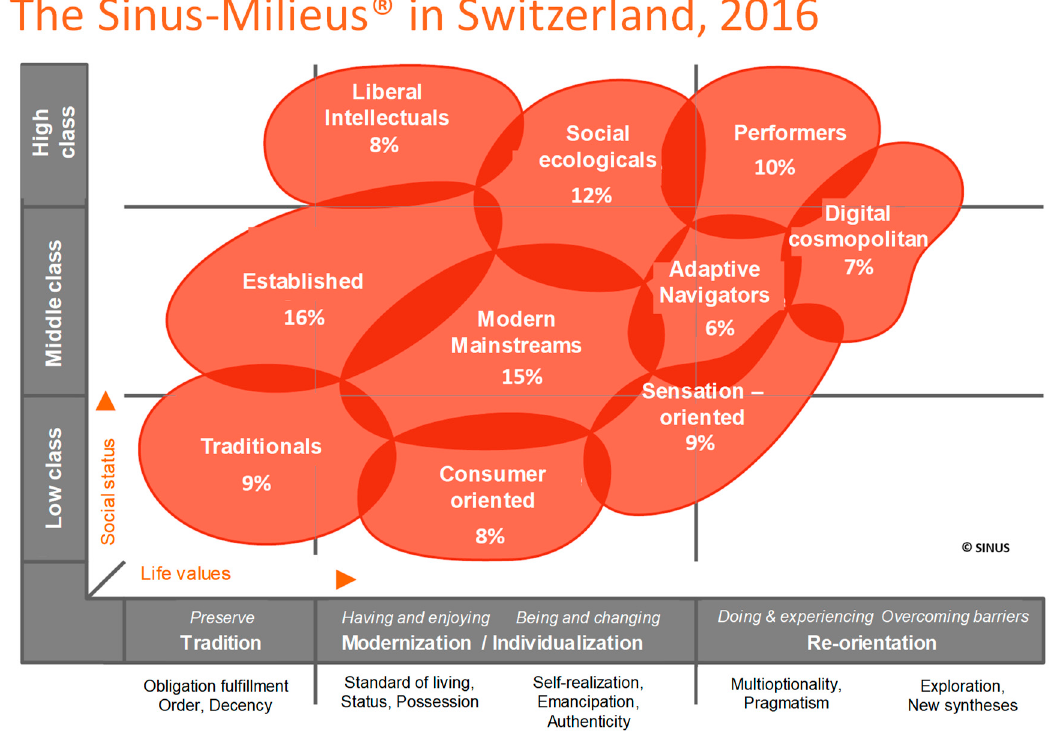
Figure A2. The Sinus-Milieus ® in Switzerland for 2016. The bubbles represent the percentage of the population belonging to a particular socioeconomic group (own translation to English from the original figure in German provided by the Sinus-Milieus ® Institute).